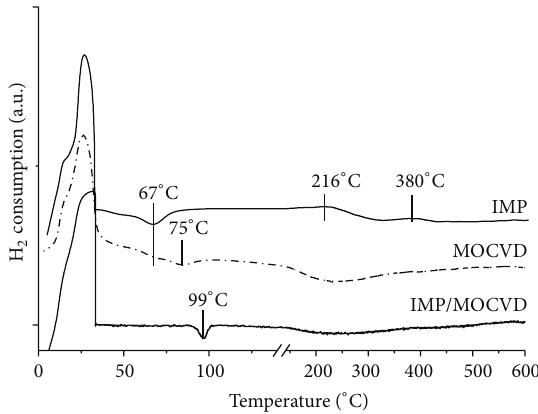
Figure 2: Reduction profiles of bimetallic Pd-Pt catalysts prepared by (a) IMP, (b) MOCVD, and (c) IMP/MOCVD